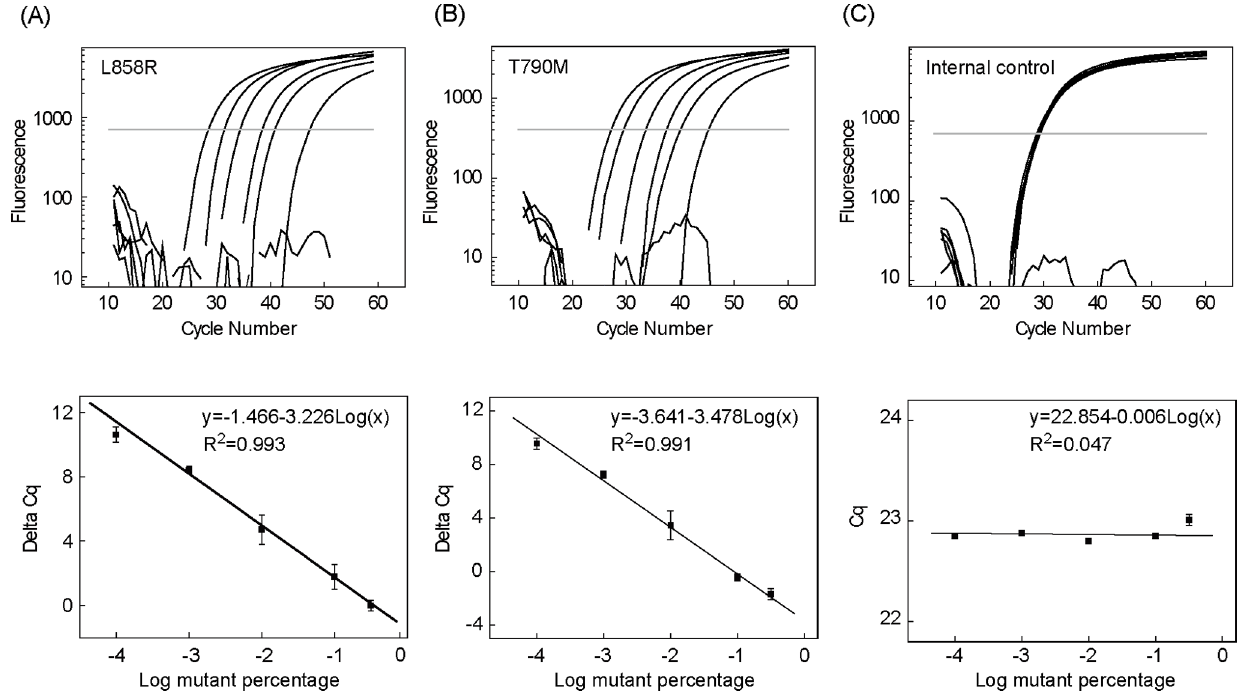
Figure 5. Quantitative performance of the three-color triplex real-time Bi-PAP. Amplification curves of 50%, 10%, 1%, 0.1%, 0.01%, and 0% mutant (from left to right) are shown for L858R (A) and T790M (B) in the upper panel. The linear relationship of the Cq difference between the mutation and the internal control ( D Cq= Cq – Cq IC ) with respect to the logarithmic mutation percentages are shown in the lower panel. Amplification curves of the internal control (C) with different mutant percentages are shown in the upper panel. The linear relationship between the Cq values of the internal control and the logarithmic mutant percentages is given in the lower panel.